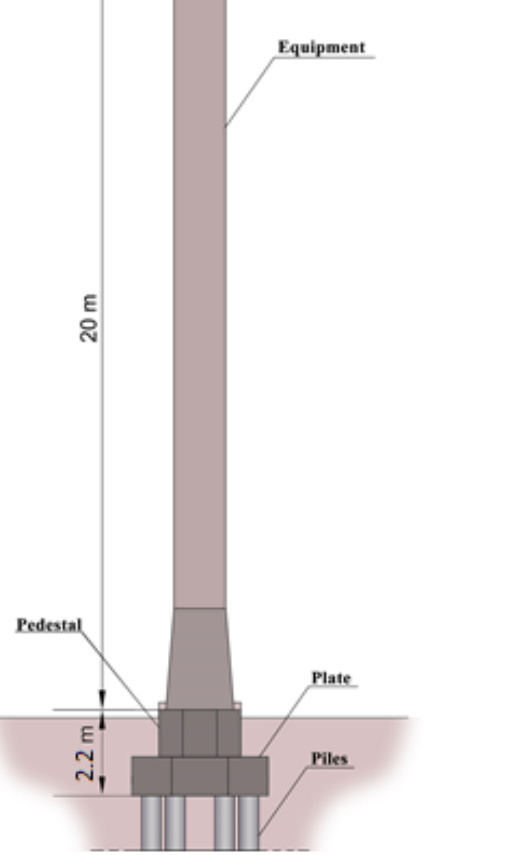
Figure 11. Scheme of the cooling tower.